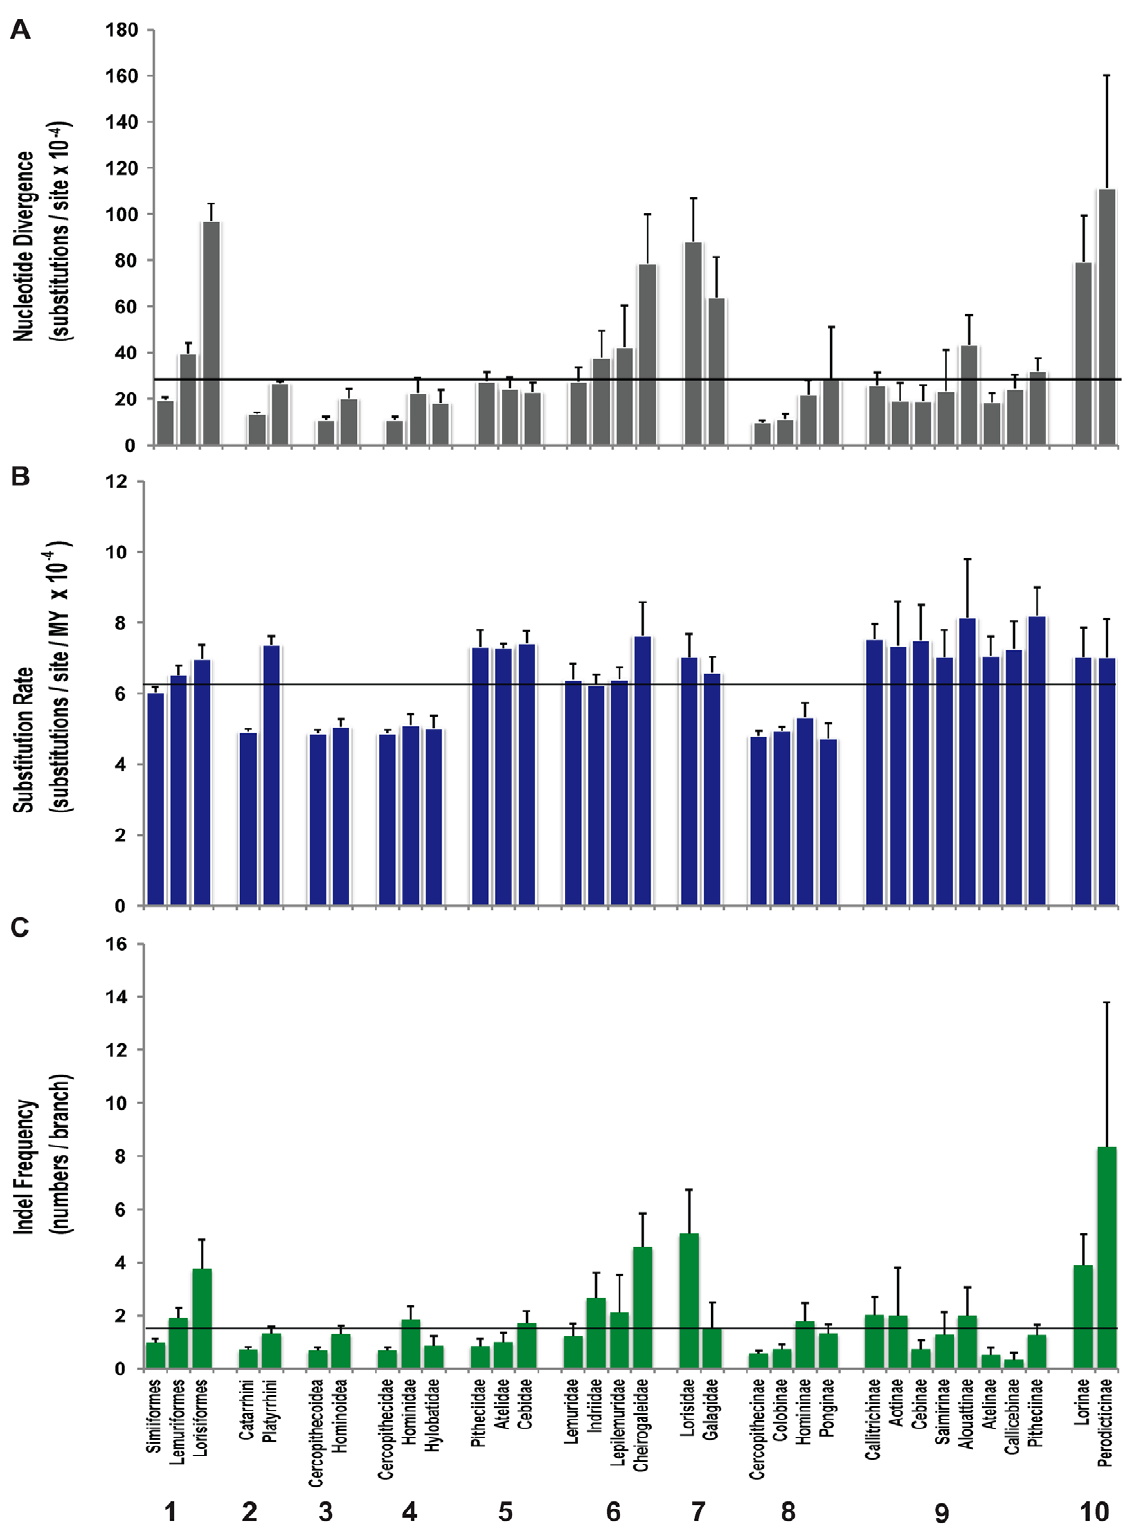
Figure 3. Patterns of nucleotide substitution and indel frequency in different categories of primate taxonomy. 1) infraorders Simiiformes, Lemuriformes, and Lorisiformes (Chiromyiformes and Tarsiiformes excluded due to small numbers of species); 2) parvorders Catarrhini and Platyrrhini; 3) superfamilies Cercopithecoidea and Hominoidea; 4) catarrhine families Cercopithecidae, Hominidae and Hylobatidae, 5) platyrrhine families Pitheciidae Atelidae, and Cebidae; 6) Malagasy strepsirrhine families of Lemuridae, Indriidae, Lepilemuridae, and Cheirogaleidae; 7) strepsirrhine families of Lorisidae and Galagidae; 8) catarrhine subfamilies of Cercopithecinae, Colobinae, Homininae, and Ponginae; 9) platyrrhine subfamilies of Callitrichinae, Aotinae, Cebinae, Saimirinae, Alouattinae, Atelidae, Calicebinae and Pitheciinae; 10) strepsirrhine subfamilies of Lorisinae